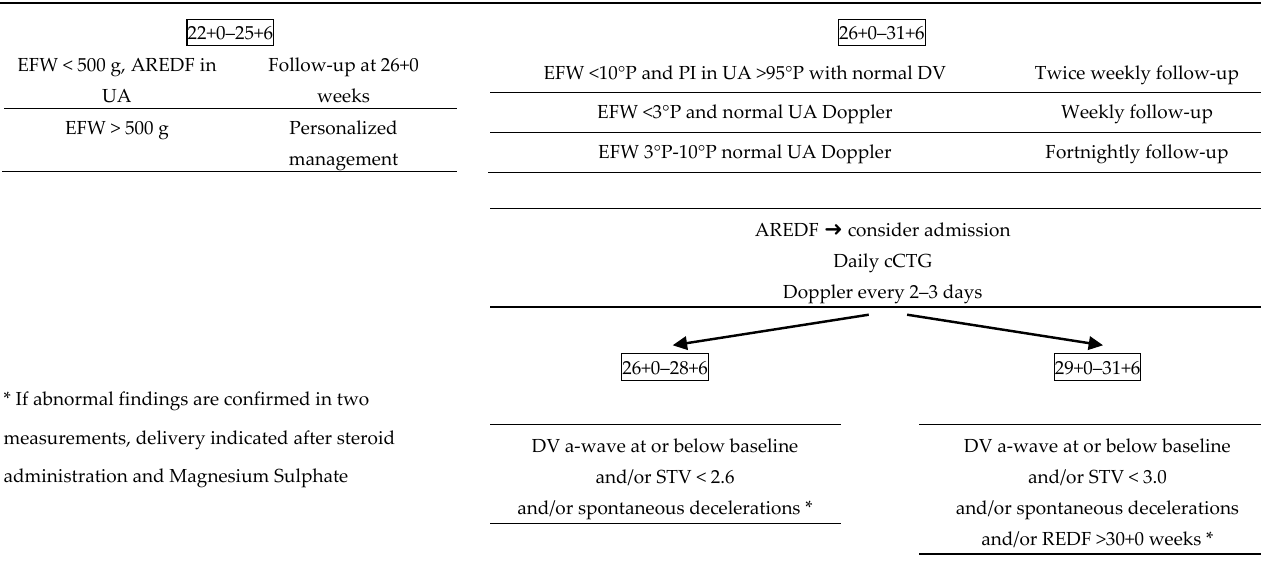
Table 1. Proposed management of non-anomalous FGR prior to 32 weeks.